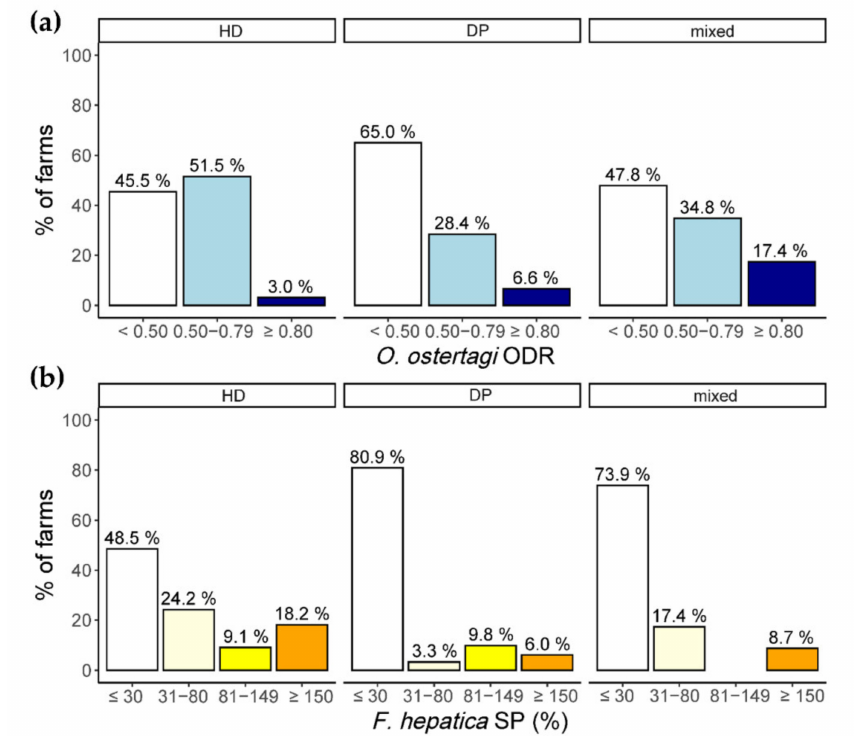
Figure 2. Distribution of O. ostertagi ( a ) and F. hepatica ( b ) BTM antibody level categories in southern Germany, according to herd breed type. Herds were defined as high-performance dairy (HD) or dual-purpose (DP) if ≥ 80% of animals belonged to the respective breed type, the remaining herds were defined as